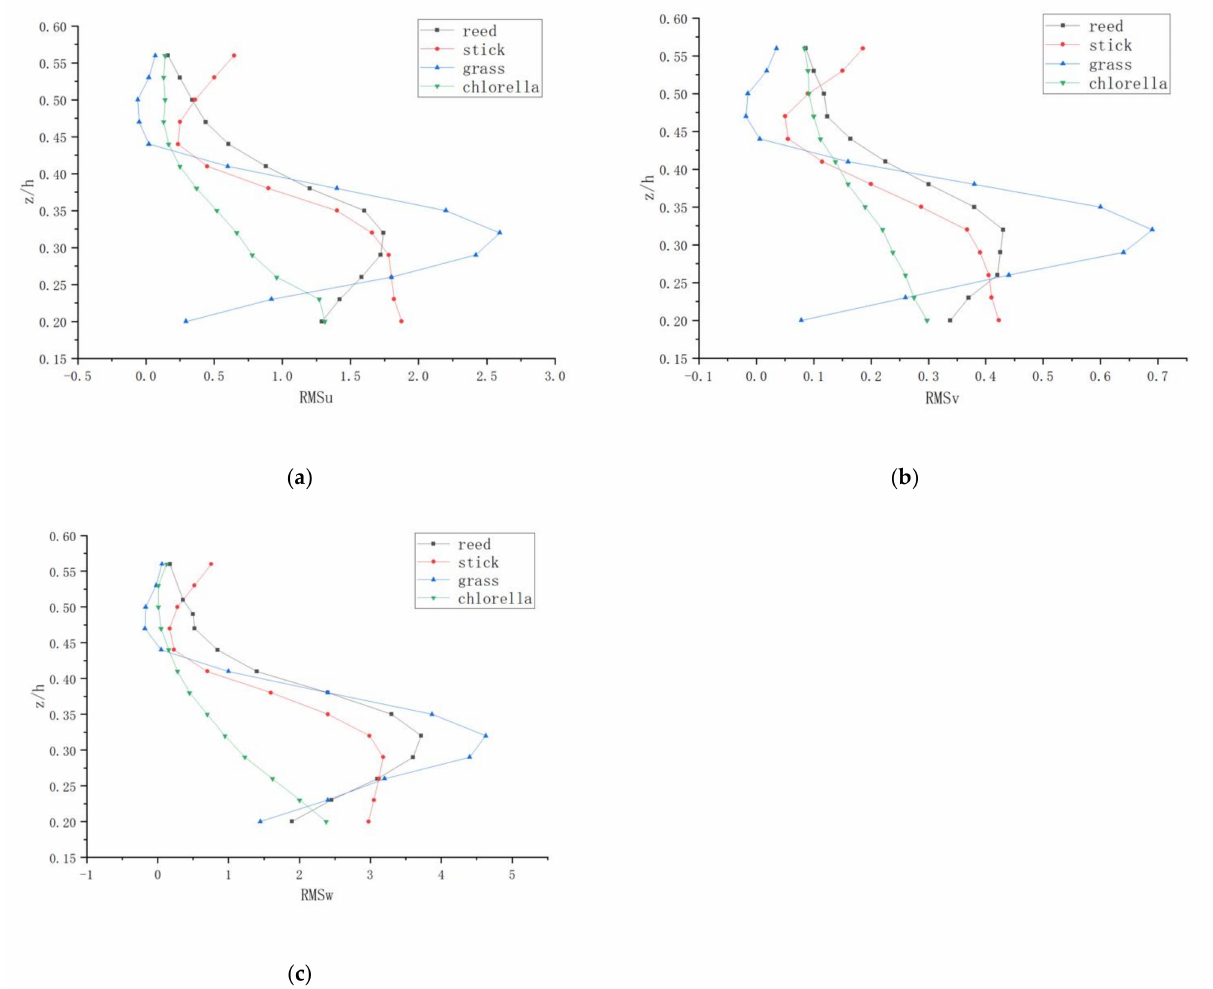
Figure 6. Vertical distributions of RMS u , RMS v and RMS w at the vertical 5 with Q = 30 L/s for different vegetations: reed and stick at the length of 30 cm, grass at the length of 10 cm, and the chlorella at the length of 5–6 cm. ( a ) Vertical distributions of RMS u ; ( b ) Vertical distributions of RMS v ; ( c ) Vertical distributions of RMS w